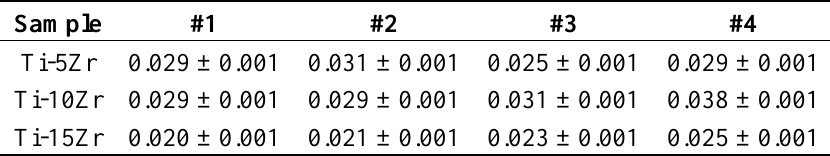
Table 2. Oxygen content of the produced samples (wt%).